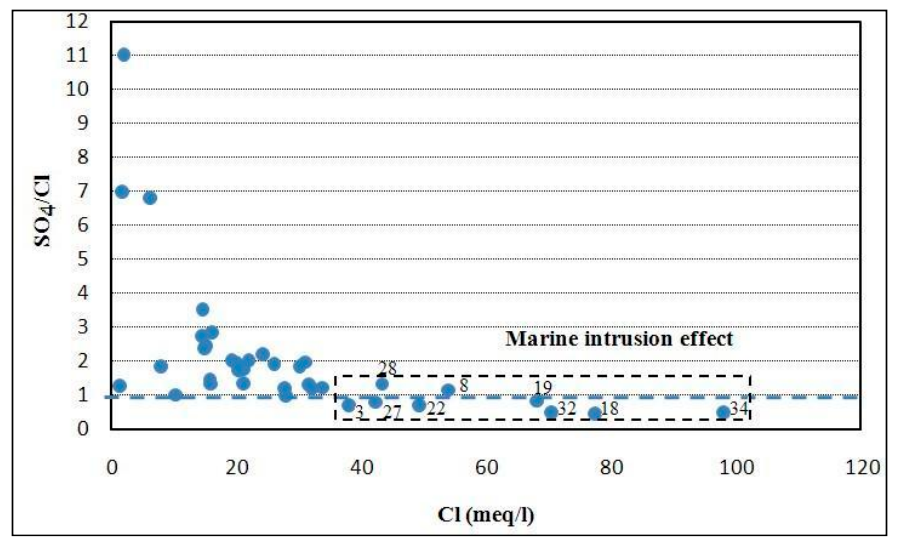
Figure 9. SO 4 /Cl vs. Cl plot in study area.